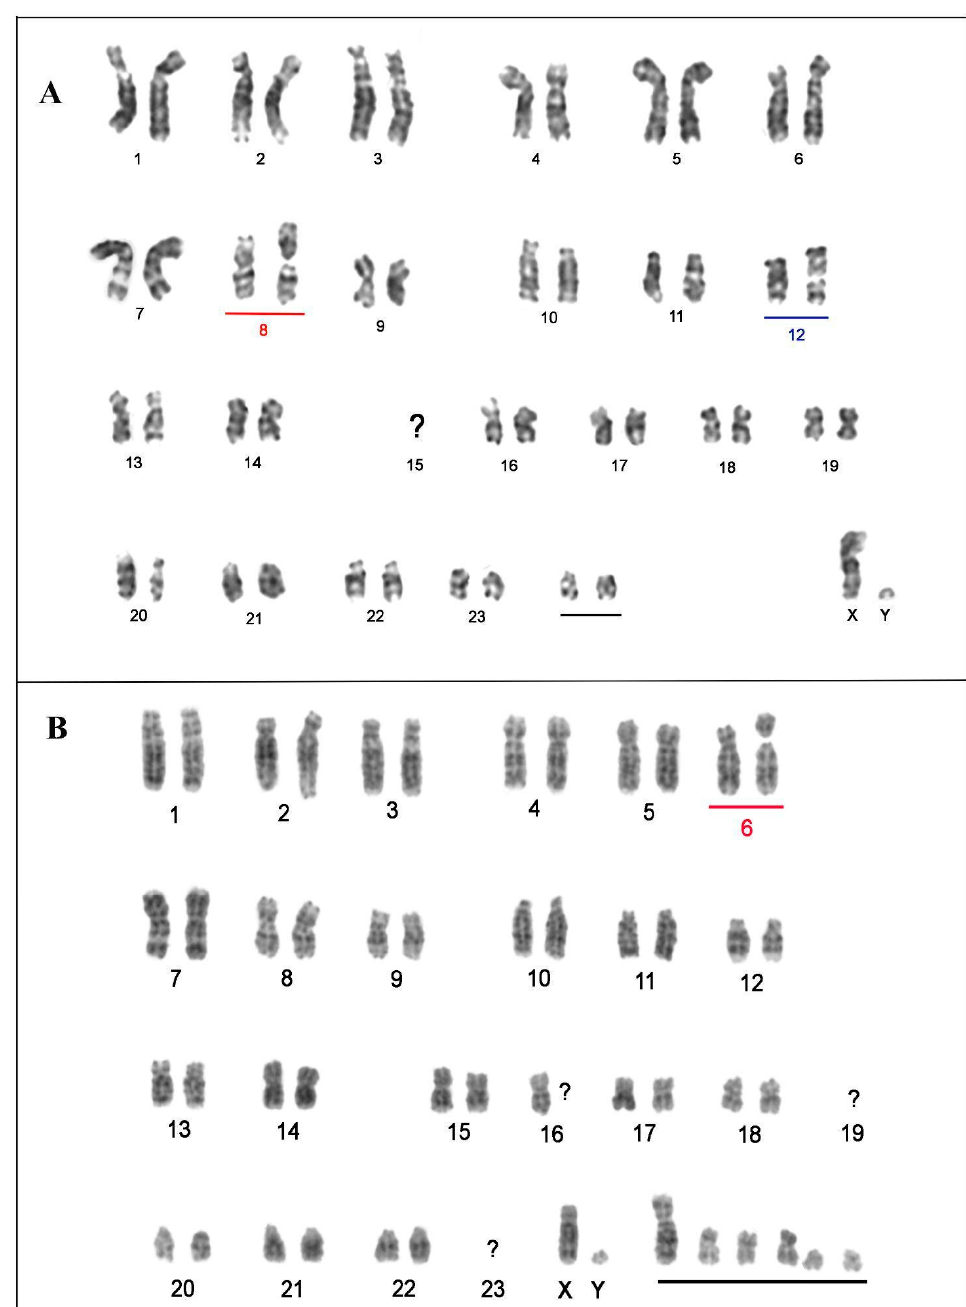
Figure 3. G-banded karyotype of hybrid specimens of manatee: ( A ). “Poque”; ( B ). “Vitor”. The blue and red bars indicate probable homologies. The black bars show chromosomes whose pairs could not be determined by the banding pattern. Bar 10 μ m.